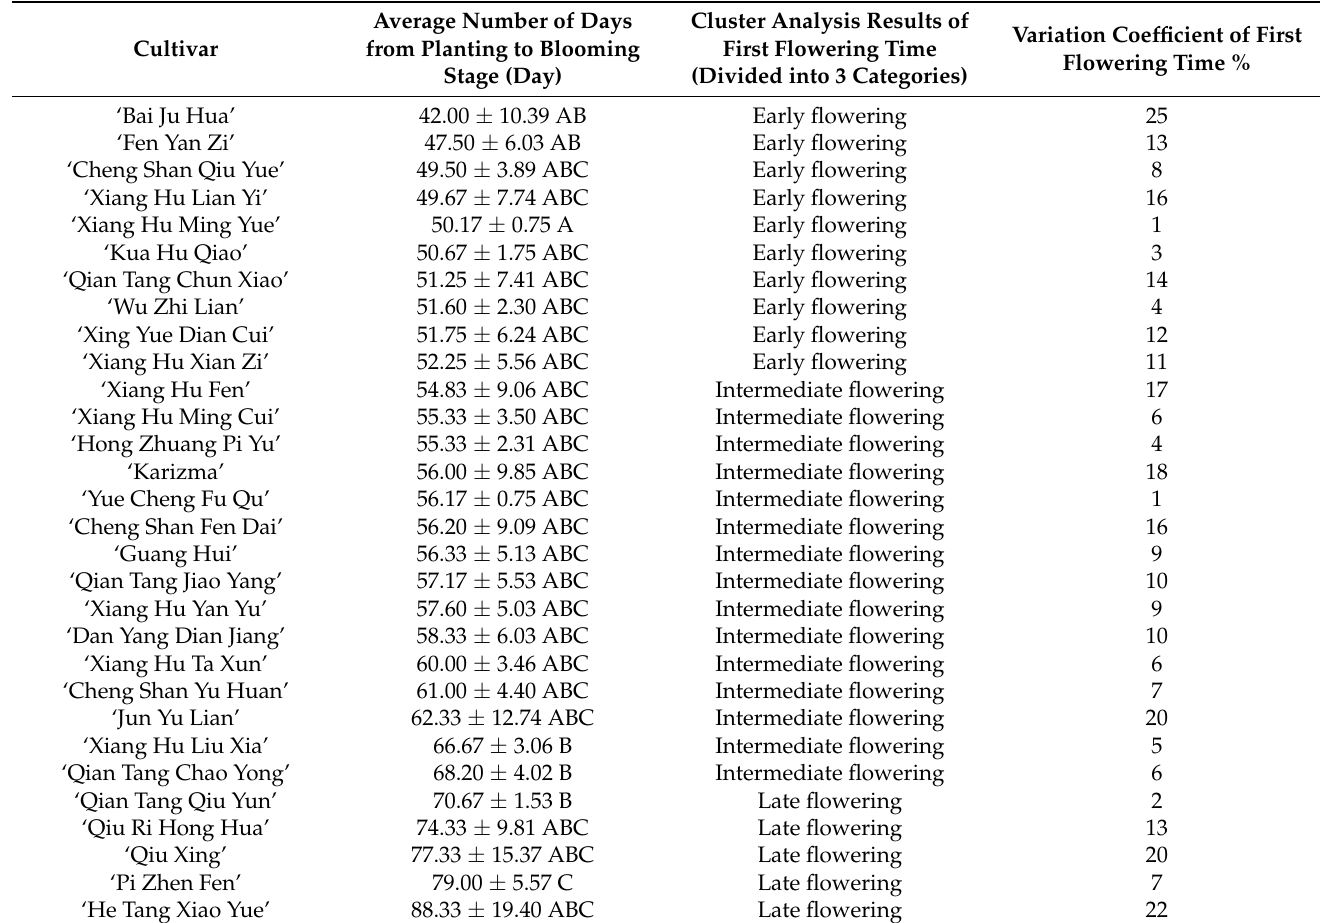
Table 1. Average number of days from planting to blooming stage of 30 Nelumbo nucifera cultivars during